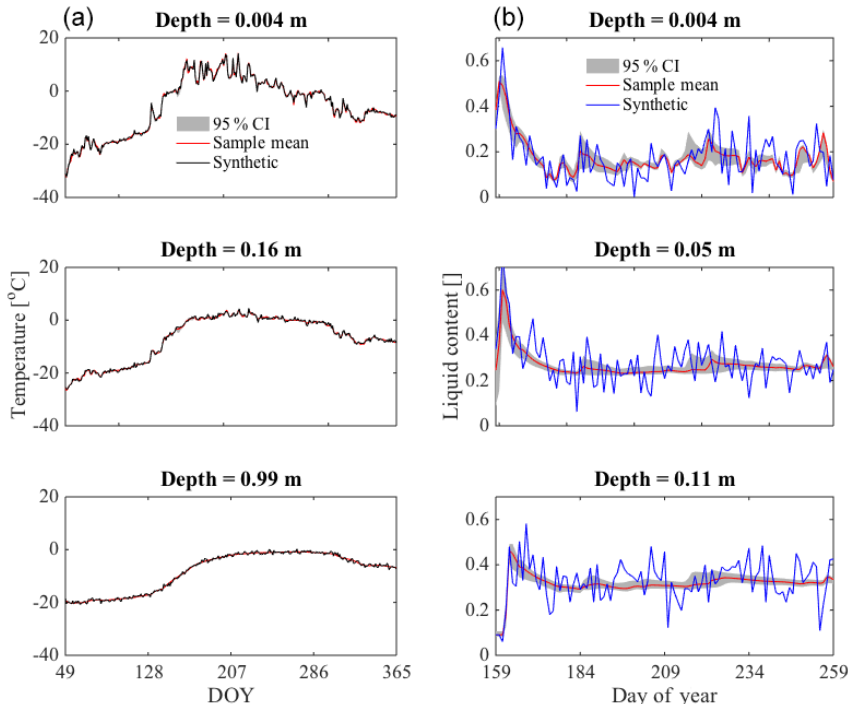
Figure 12. Comparison of “observation” and predicted soil temperature at z = 0 . 004, 0.16 and 0.99m (a) and liquid water content at z = 0 . 004, 0.05 and 0.11m (b) . The blue line denotes the synthetic data. The grey region represents the 95% confidence interval calculated from the a posteriori MCMC samples of scenario 8. The red line represents the mean of samples.